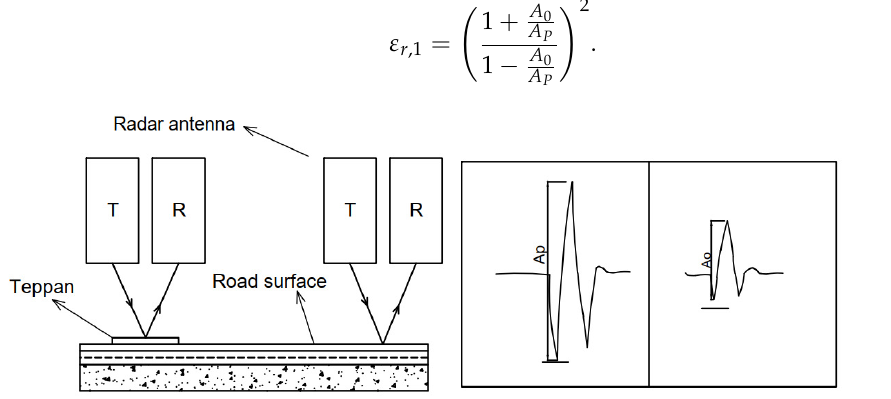
Figure 4. Schematic diagram of total reflection detection method of three-dimensional ground- penetrating radar.